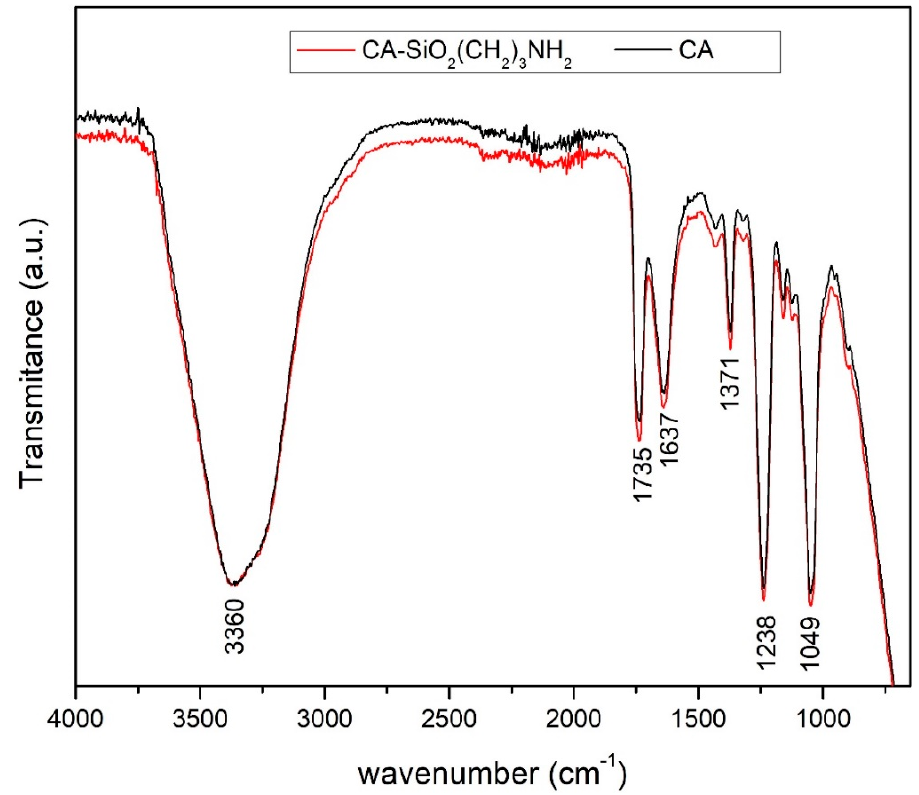
Figure 5. Wide-range ATR-FTIR spectra (4000–650 cm − 1 ) of the CA-SiO 2 -(CH 2 ) 3 NH 2 and CA membranes.